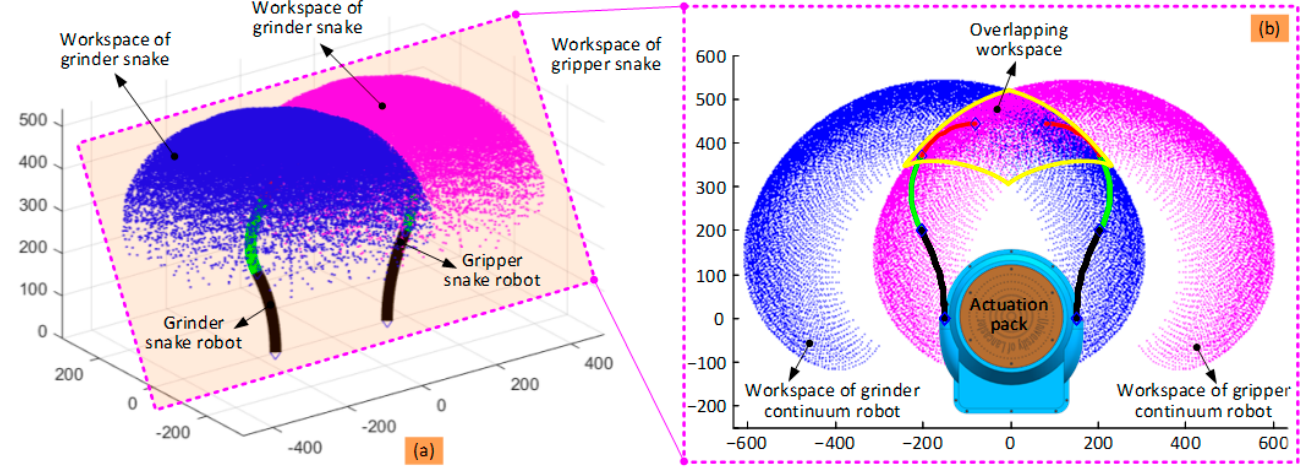
Figure 4. Cooperative workspace of the dual-arm continuum robot: ( a ) is the overall view of the workspace for the two continuum robots; ( b ) is the section view of the cooperative workspace. Note: for visibility, the bending ranges for the three sections of the two continuum robots in ( a ) are 30°, 45°, and 60°, respectively, while it is 90° in ( b ). The phase angles are within [0°, 360°] in both ( a ) and ( b ).